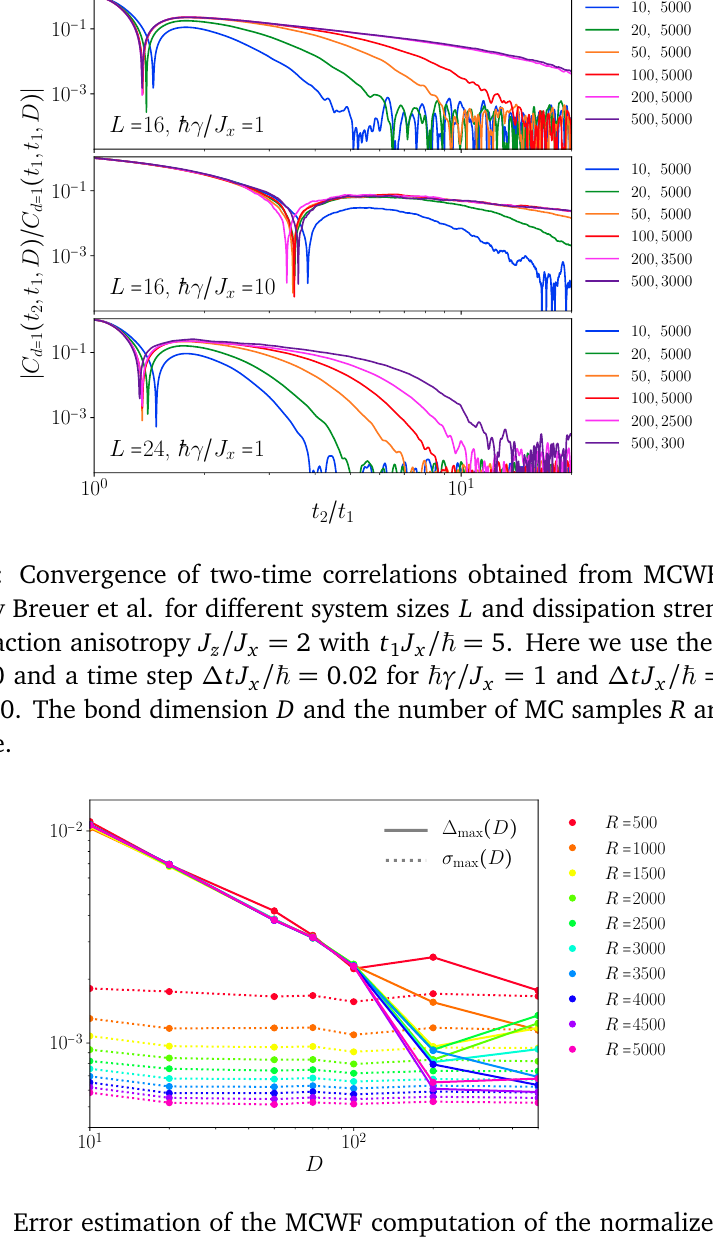
= 1, J / J = 2, t / (cid:126) = 5 and a time J x z x x 1 and the max for different number of trajectories R . The max